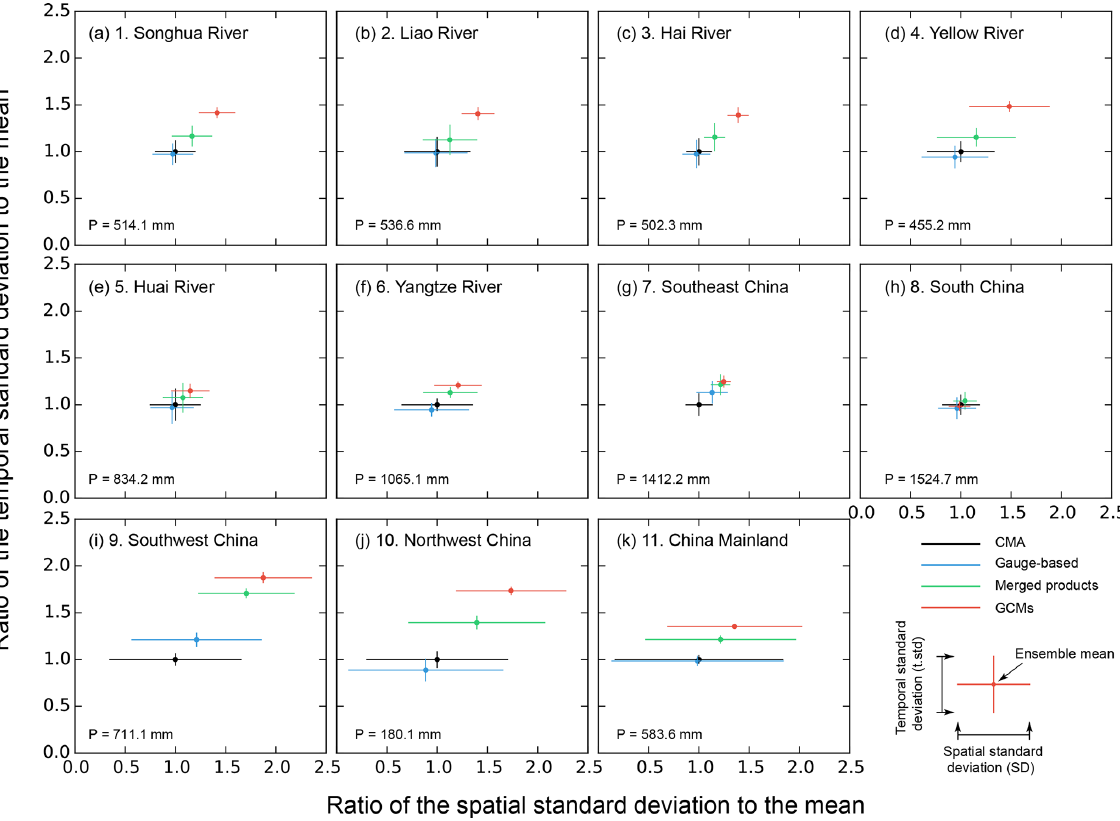
Figure 7. Spatial standard deviation (horizontal) and temporal standard deviation (vertical) of the annual precipitation across ensemble datasets in each of the different precipitation groups for each subregion. The P value in the bottom left is the annual precipitation of CMA. The cross centre represents the long-term means of the regional annual precipitation in ratio to the CMA mean value. The horizontal error bar represents the spatial standard deviation (spatial variation of the long-term annual precipitation at all the grids). The vertical error bar represents the temporal standard deviation (temporal variations of region-averaged annual precipitation in different